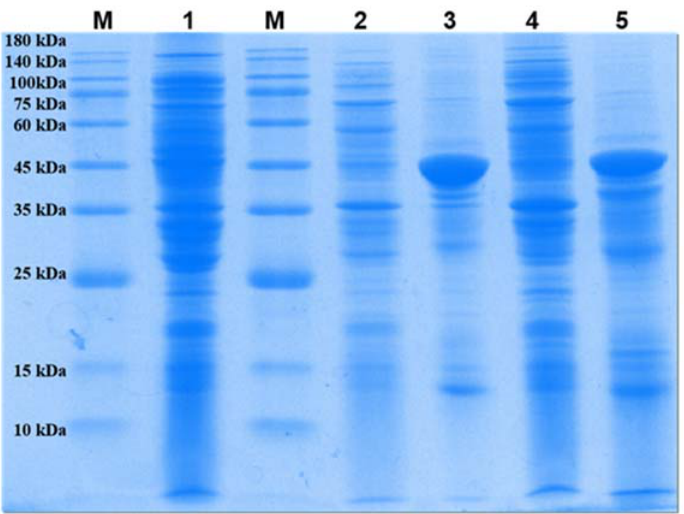
Figure 1. SDS ‐ PAGE analysis of PLB expressed in E. coli BL21(DE3). Lane M: protein molecular weight marker; lane 1: supernatant of E. coli BL21(DE3); lane 2: supernatant of E. coli BL21(DE3)/pET28a ‐ PLB induced at 30 °C with 0.5 mM of IPTG; lane 3: precipitation of E. coli BL21(DE3)/pET28a ‐ PLB induced at 30 °C with 0.5 mM of IPTG; lane 4: supernatant of E. coli BL21(DE3)/pET28a ‐ PLB induced at 20 °C with 0.1 mM of IPTG; lane 5: precipitation of E. coli BL21(DE3)/pET28a ‐ PLB induced at 20 °C with 0.1 mM of IPTG.